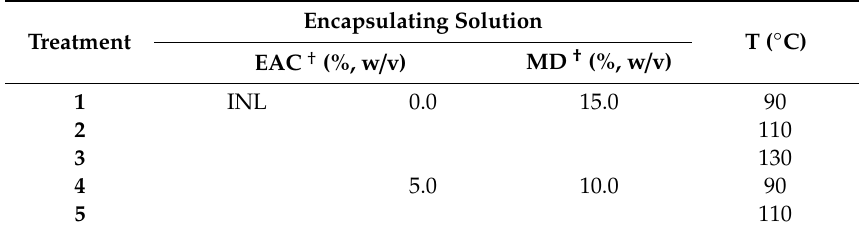
Table 1. A design central composite face-centered with two variables, encapsulating agent (chia